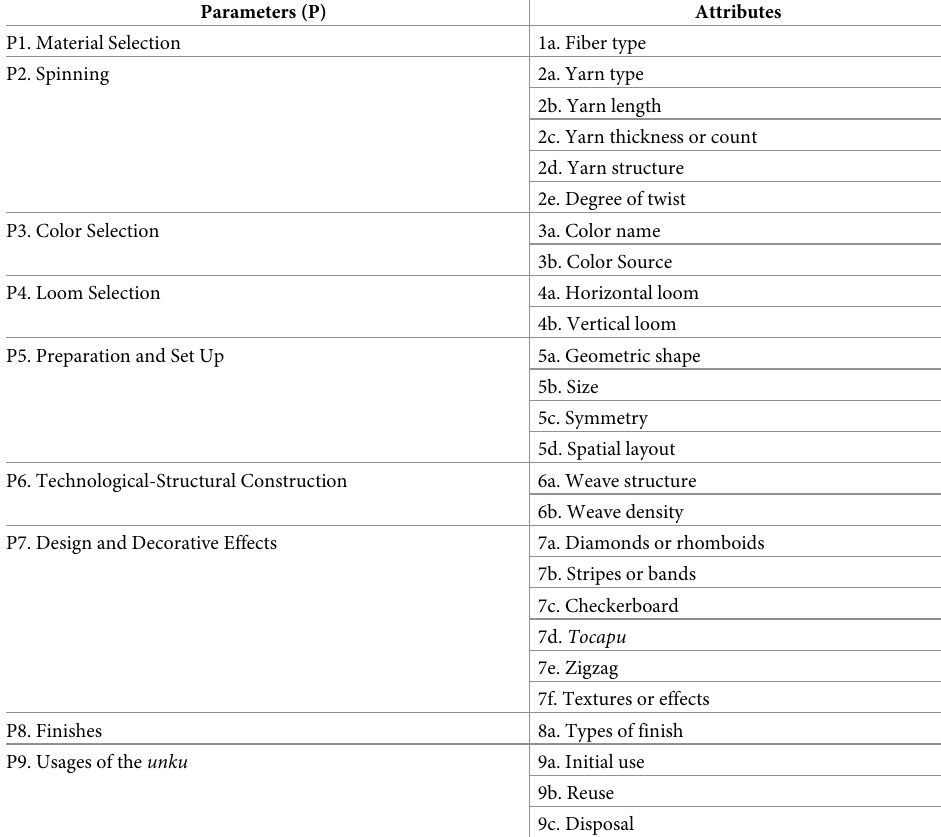
Table 1. Standard analytical parameters and